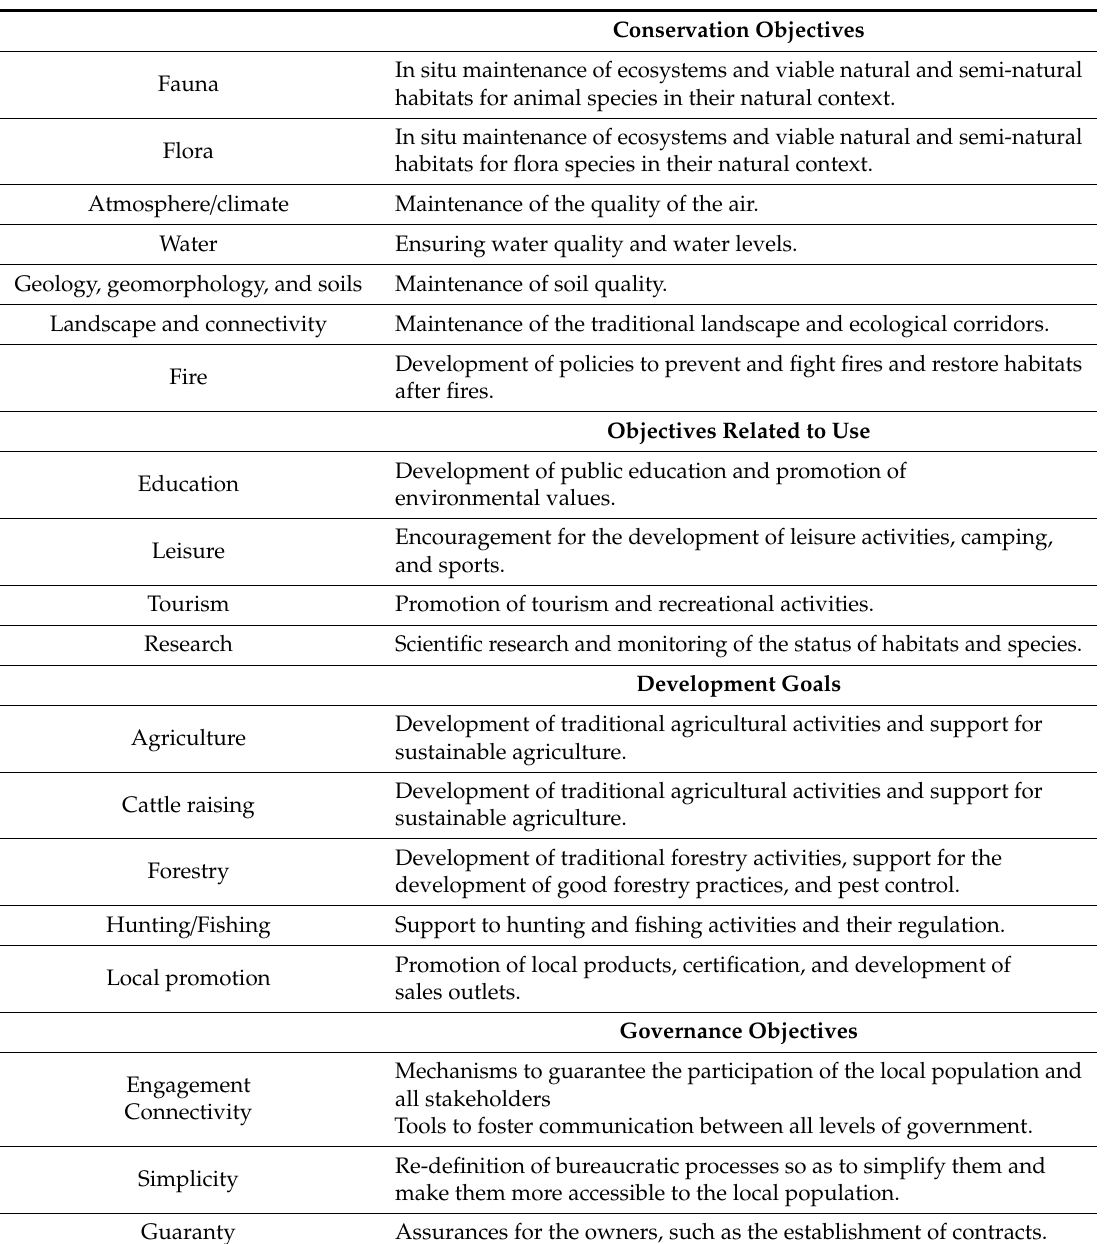
Table 1. Description of the management objectives behind the planning of the Iberian Plateau